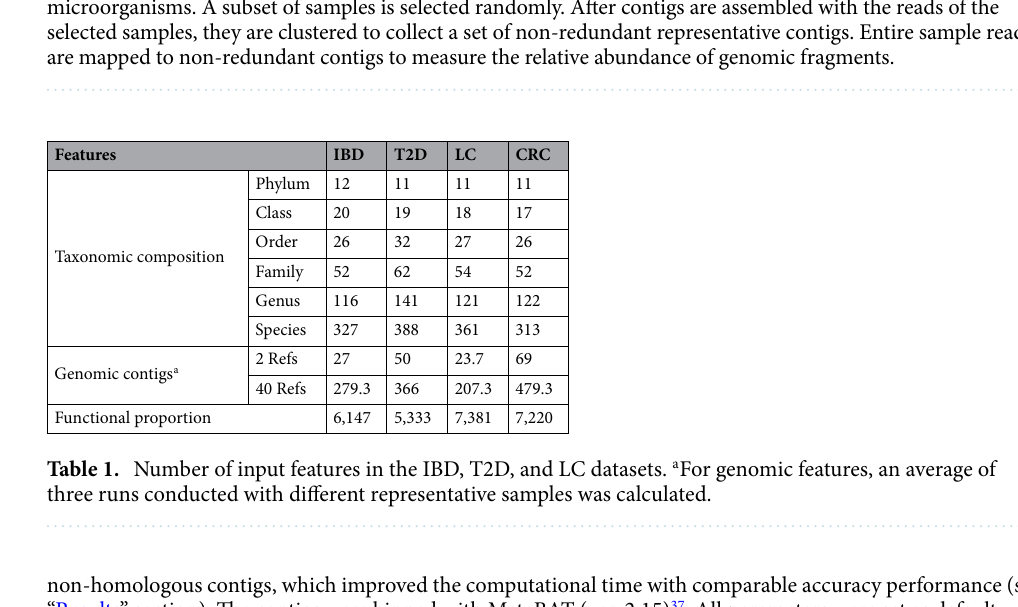
non-homologous contigs, which improved the computational time with comparable accuracy performance (see “Results” section). The contigs were binned with MetaBAT (ver. 2.15) 37 . All parameters were set as default with no depth file as an option when running MetaBAT. The longest contig in each bin was selected and gathered as non-redundant representative contigs for feature generation. The reads in each sample were mapped to non-redundant contigs using Bowtie (ver. 2.3.4.1) 34 . For each pair of a sample and non-redundant contig, the values of reads per kilobase per million mapped reads (RPKM) were calculated as follows: